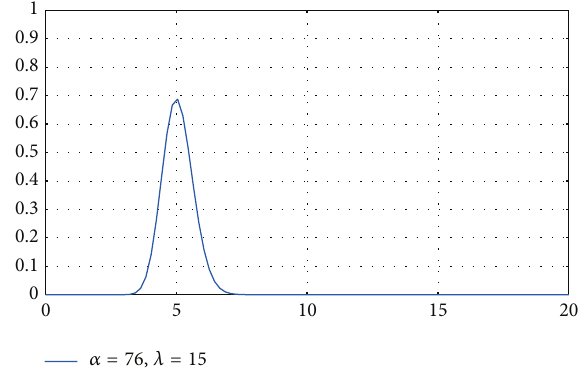
Figure 1: Erlang plots for different 𝛼 and 𝜆